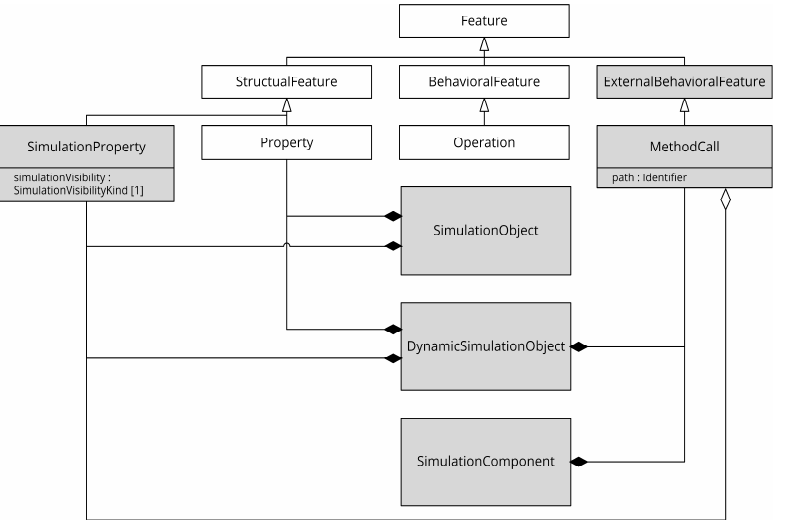
Figure 18. Simplified view on the internal structure of the newly introduced SimulationObject related meta-classes (cf. Figure 17). White boxes represent existing UML metamodel elements and gray boxes represent newly added